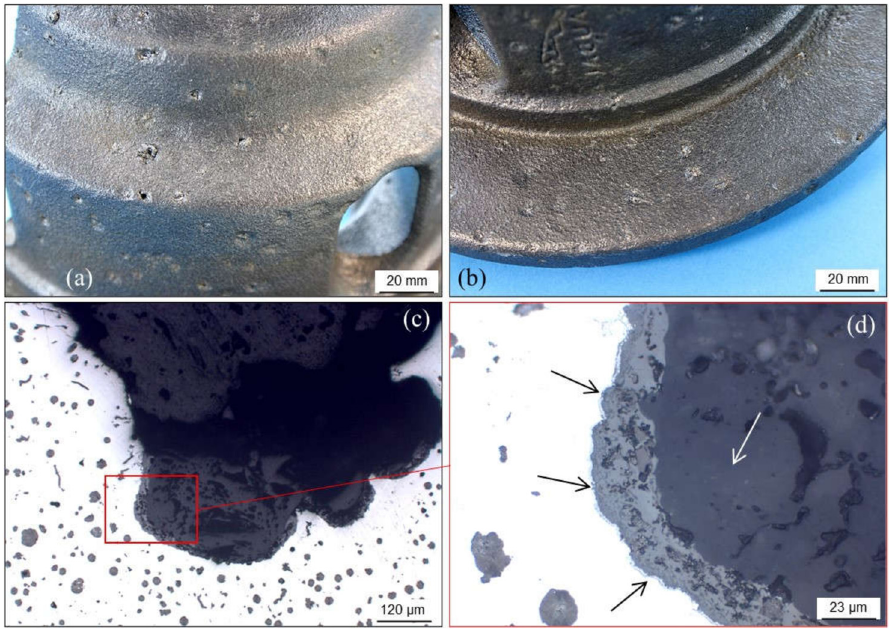
Figure 54. Surface defects found in a ductile iron casting manufactured with highly contaminated green sand mixtures. Macroscopic views of these defects in different areas of the casting ( a , b ) and metallographic views ( c , d